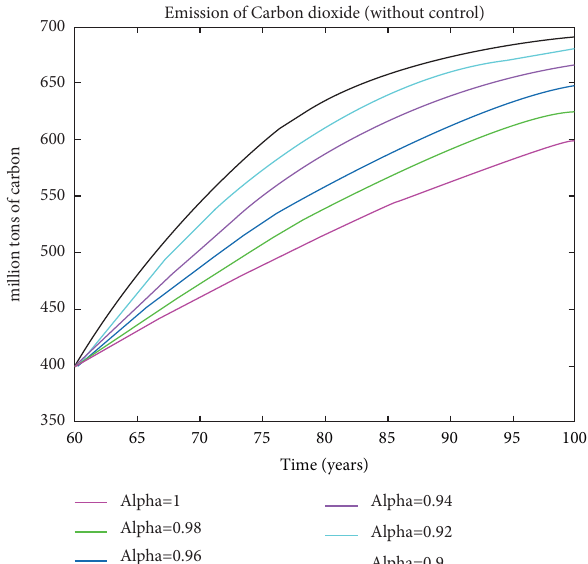
Figure 7: Comparison of the amount of CO 2 without control with diferent values of alpha.